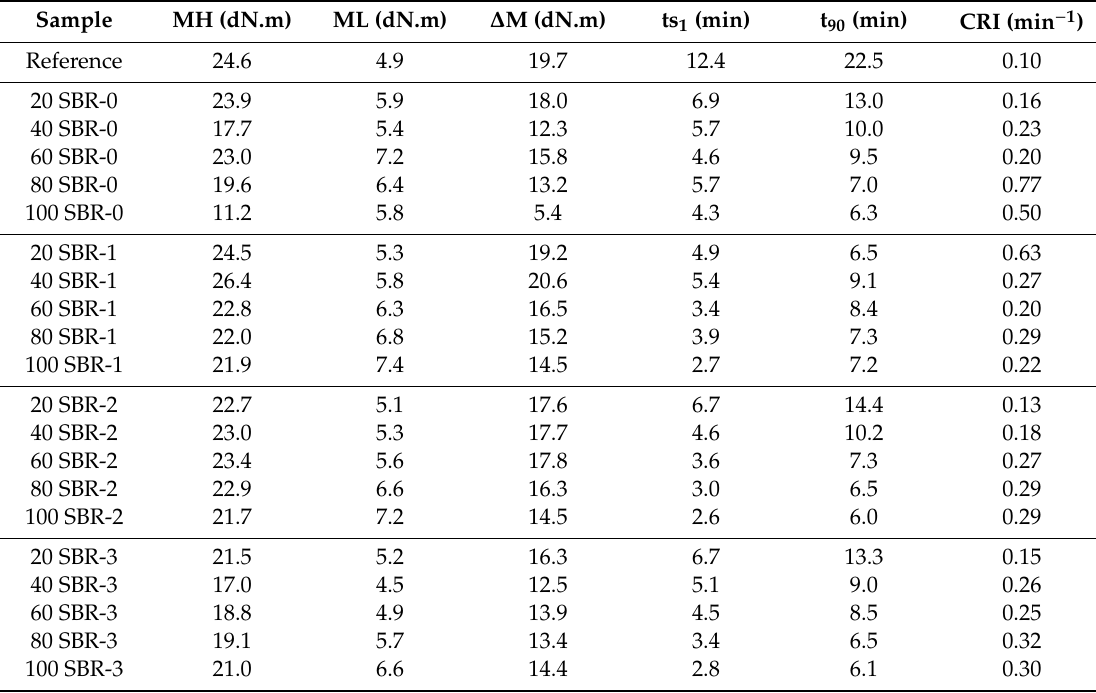
Table 2. Vulcanization characteristics of the